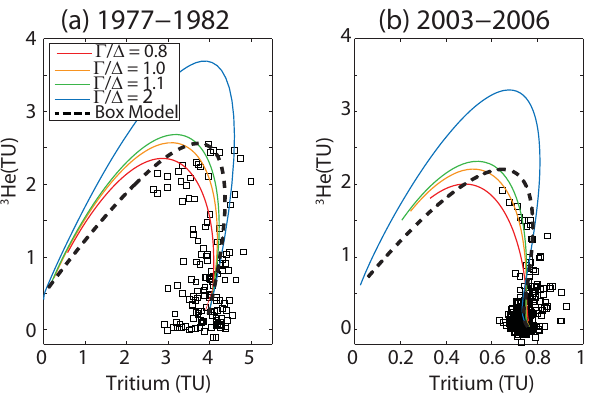
Fig. 9. Tritium and 3 He data (black squares) from the upper 500m ( σ θ < = 26 . 6kgm − 3 ) from (a) 1977–1982 and from (b) 2003–2006 (this study) were used to constrain 0/1 , a ratio necessary for the TTD approach. The curves represent the ensemble of 0 in 3 He/T space predicted by the TTD model for a fixed 0/1 ratio. For the data presented in this study, a range of 0/1 of 0.8 to 2.0 seems reasonable. From the older data, it can be seen that a tighter range of 0/1 of 0.8 to 1.1 is more suitable. Also plotted (black dashed line) is the T and 3 He predicted by the box model